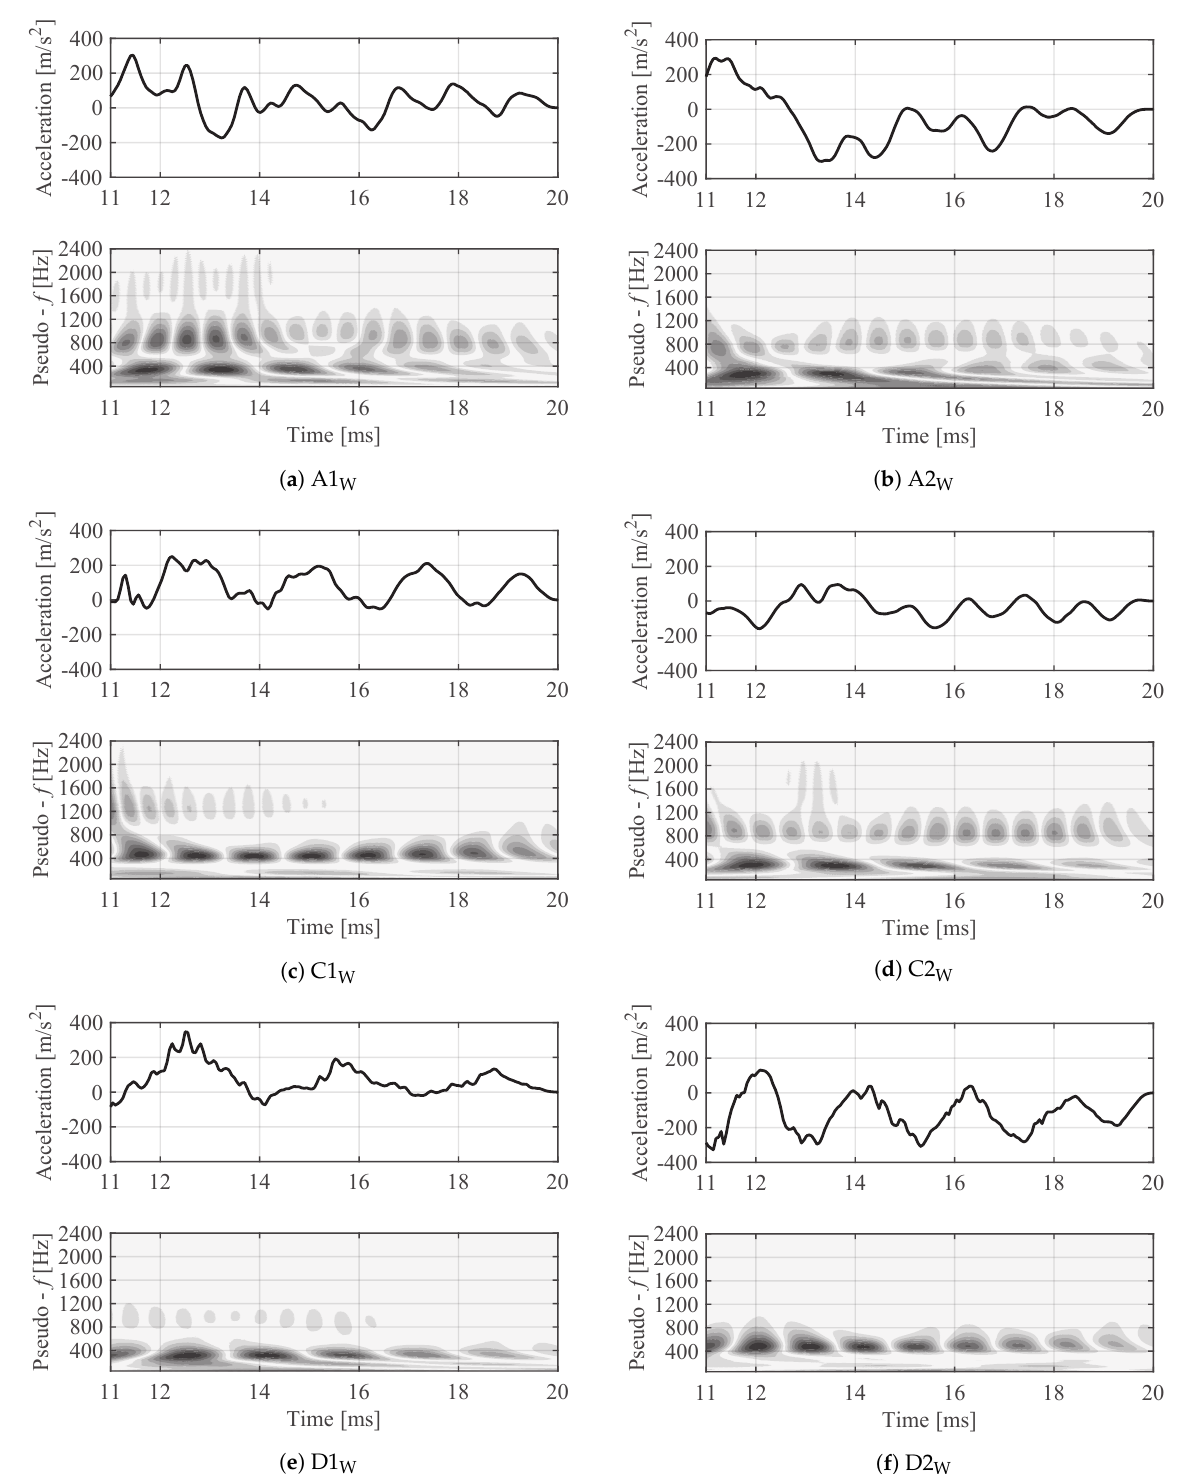
Figure 14. Acceleration and time–frequency scale-space from CWT of the signal measured at the west accelerometer for Beams A1, A2, C1, C2, D1, and